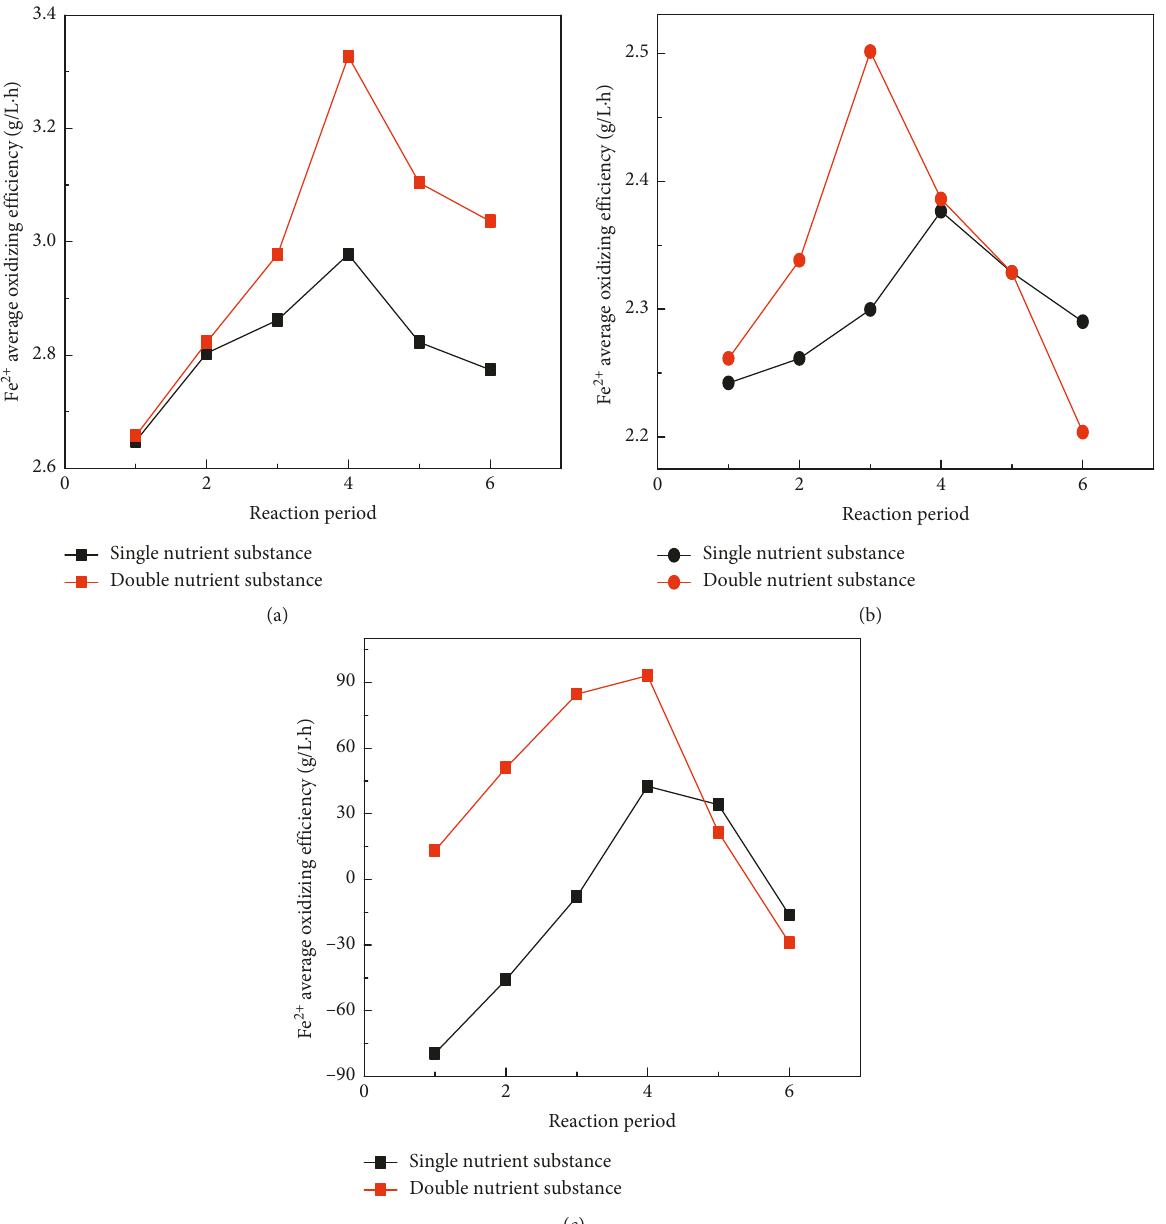
Figure 8: Effect of nutrient content on production efficiency of BPFS: (a) 40kg/m 3 BPFS; (b) 60kg/m 3 BPFS; (c) 80 kg/m 3